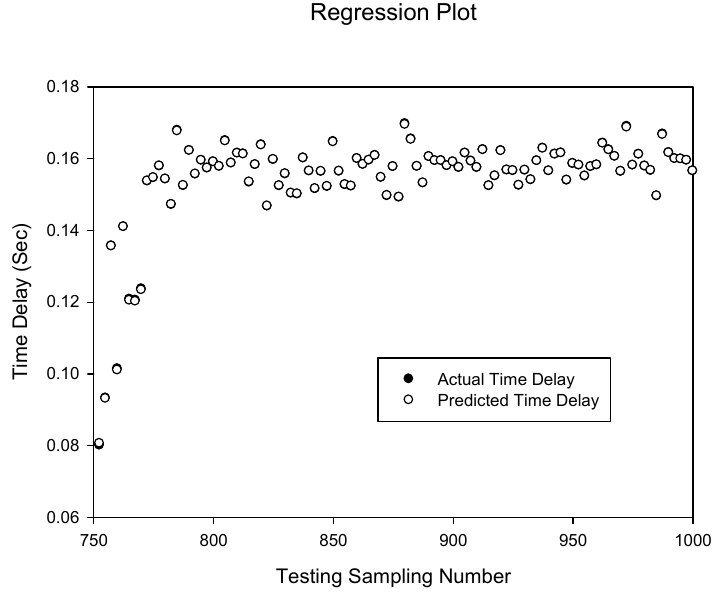
Regression Plot